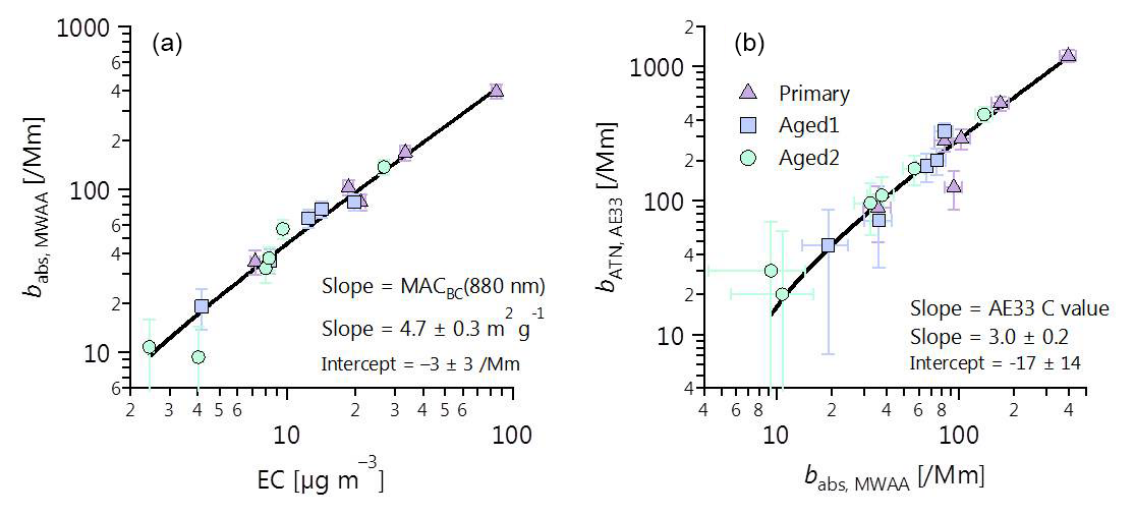
Figure 1. Determination of (a) MAC BC (880nm) and (b) Aethalometer C value using MWAA absorption measurements, thermal–optical EC (EUSAAR2 protocol), and Aethalometer attenuation measurements. MWAA absorption measurements at 880nm are determined by extrapolating the absorption coefficients at 850nm using an α determined from the ratio between the absorption coefficients at 850 and 635nm. The aerosols were either primary (no OH exposure), Aged 1 ( ∼ 1 × 10 7 molecOHcm − 3 h) or Aged 2 ( ∼ 4 × 10 7 molecOHcm − 3 h). No difference in MAC or C value was discernable with aging (see also Fig. S2). The C value derived from σ ATN recommended by Drinovec et al. (2015) = 2 . 6 compares well with the value derived in Fig.